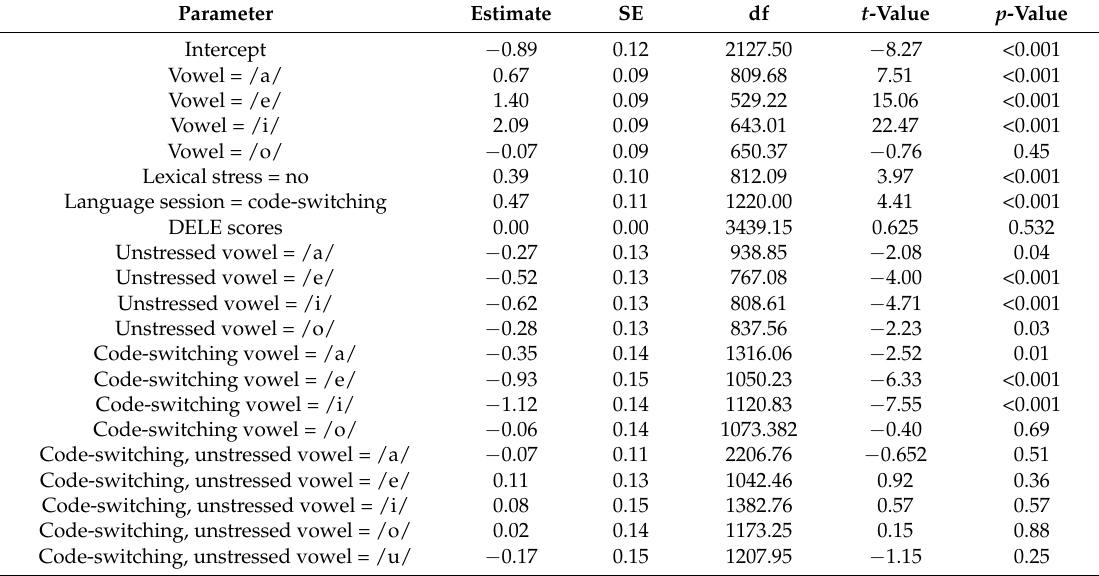
Table 5. Results from the linear mixed effects model for normalized F2